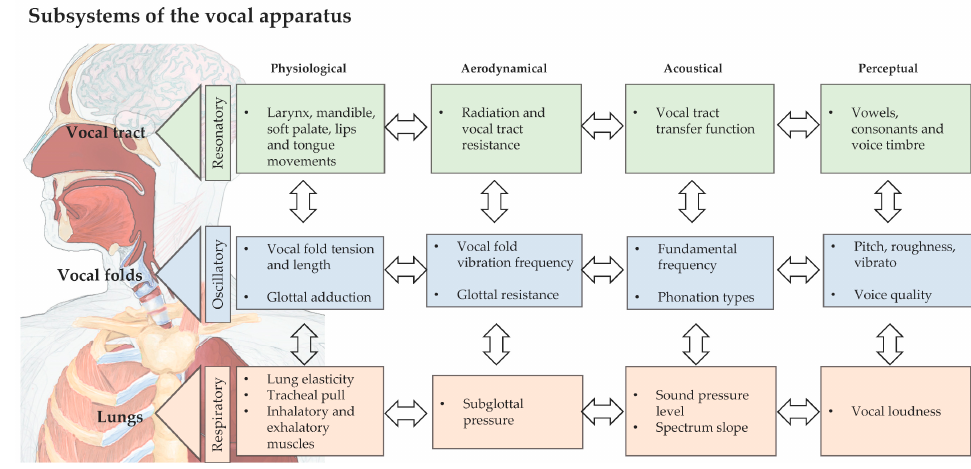
Figure 1. Schematic representation of the subsystems that constitute the vocal apparatus and under- lying physiological, aerodynamical, acoustical and perceptual correlates.